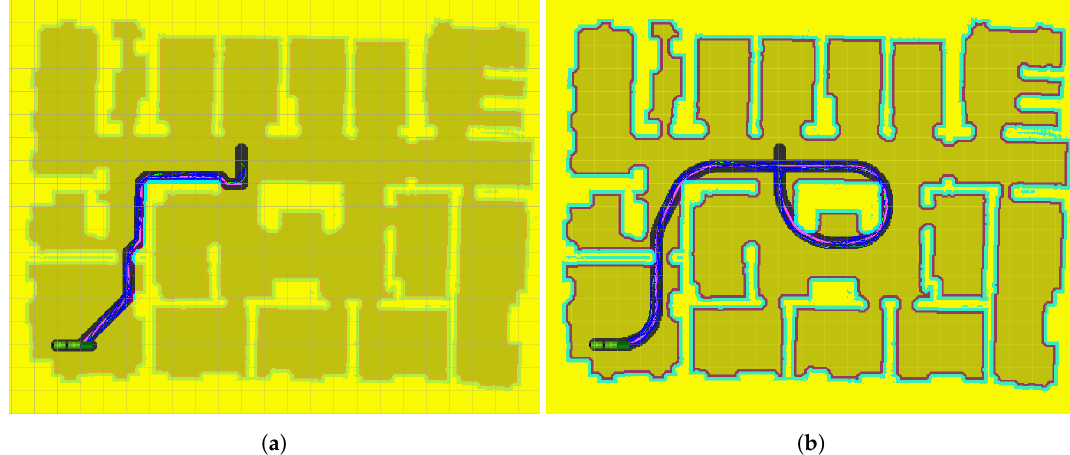
Figure 17. Goal 4 results: ( a ) Path planning with ARA*-RRT*; ( b ) Path planning with